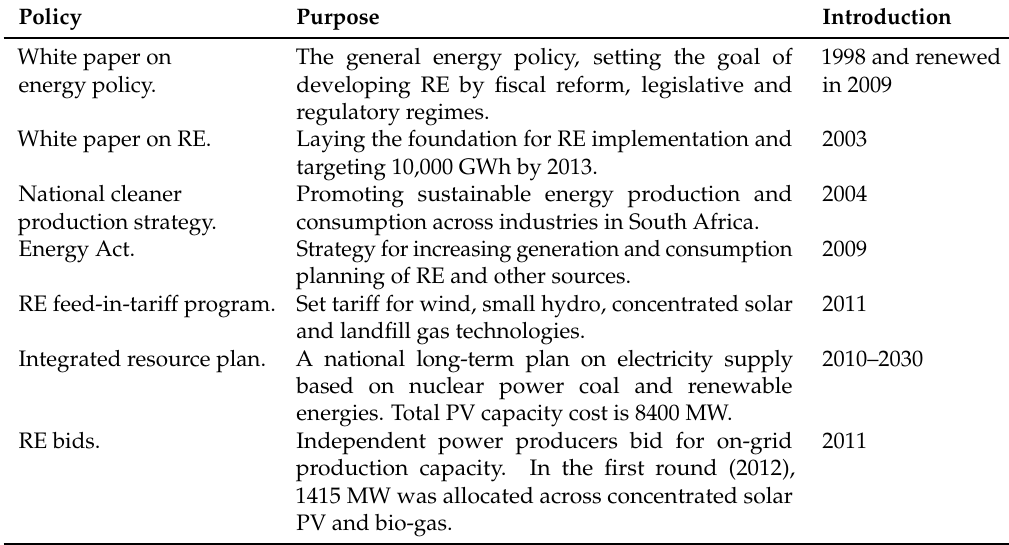
Table 7. The summary of the policies and purposes related to RE in South Africa